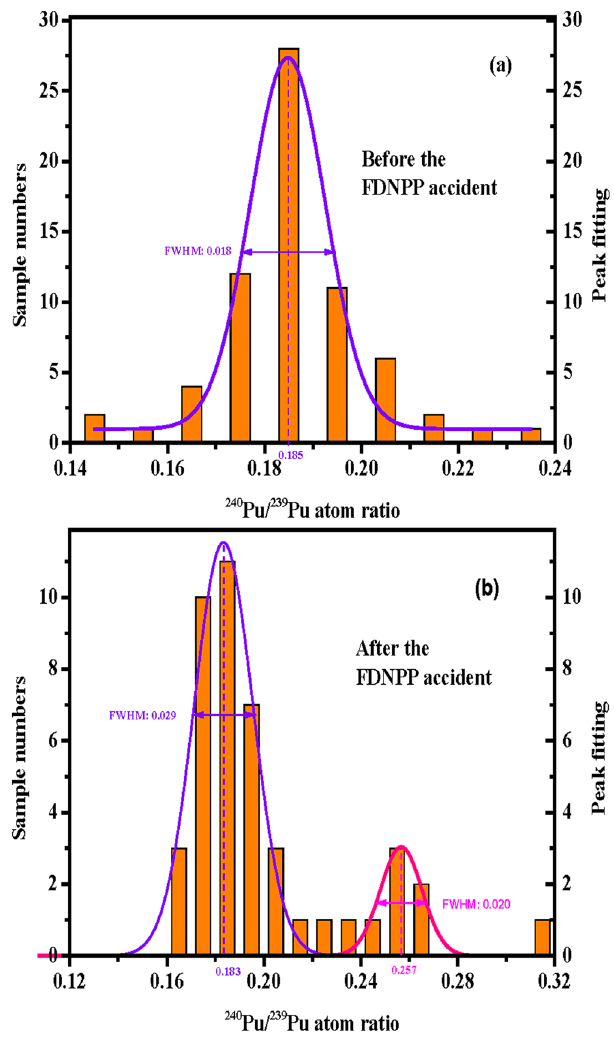
Figure 3. Frequency distributions of 240 Pu/ 239 Pu atom ratios ( a ) in soil samples before the FDNPP accident 3 and ( b ) in soil samples after this accident (FWHM: full width at half